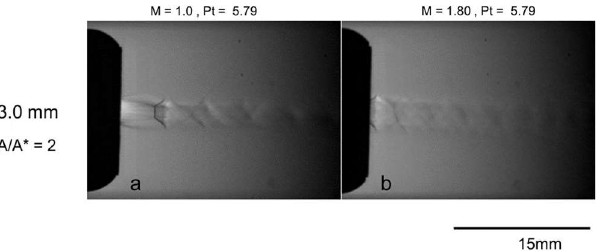
Figure 4. Wave pattern observed in shadowgraph imaging at 20,000 frames per second for the ( a ) converging nozzle and ( b ) CD nozzle at 35 kg/hr airflow rate. ( a ) converging nozzle and ( b ) CD nozzle at 35 kg/h airflow